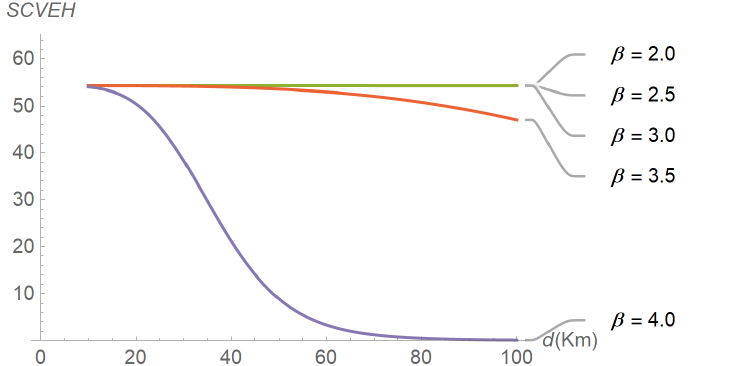
Figure 8. Evolution of the squared coefficient of variation in terms of distance, for different path- loss exponents. The shadowing spread and the Nakagami parameter have been set to 8.5 and 5.0, respectively.